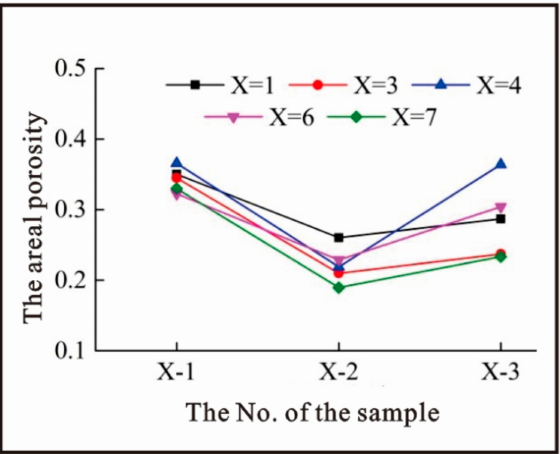
Figure 9. Areal porosities of the samples, obtained through scanning electron microscopy